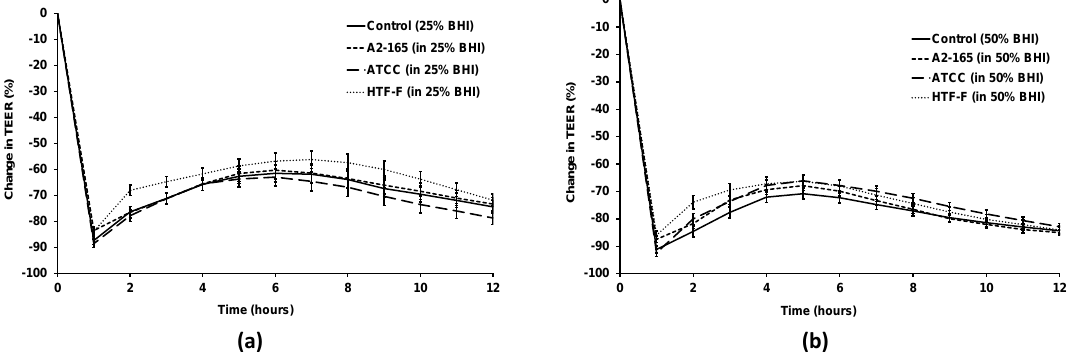
Figure 5. Change in TEER across Caco-2 monolayers co-cultured with live F. prausnitzii using 25% and 50% BHI as apical medium. Differentiated Caco-2 monolayers were co-cultured with the three F. prausnitzii strains for 12 h in the apical anaerobic co-culture model using 25% or 50% BHI as apical medium. The interaction between the treatment and time was significant for the change in TEER ( p < 0.001). The graphs show the mean (±SEM; n = 12) change in TEER across Caco-2 monolayers when using ( a ) 25% BHI and ( b ) 50% BHI as apical medium. No differences were determined between the two control media and the three F. prausnitzii strains in the respective medium at any time point ( p > 0.05).